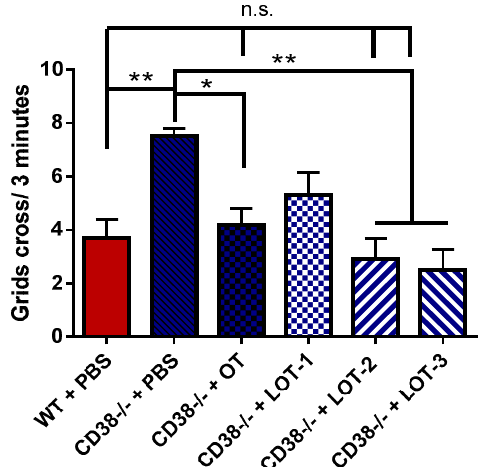
Figure 7. Locomotor activity in mouse pups. Pups of 38 +/+ (WT) and CD38 − / − mice were subjected to the grid crossing test 30 min after a single i.p. injection of PBS, OT, LOT-1, LOT-2, or LOT-3. A one-way ANOVA followed Bonferroni’s post hoc test was performed ( F 9,125 = 6.047, p = 0.0001). * p < 0.05, ** p < 0.01 in each comparison. n.s., not significant.